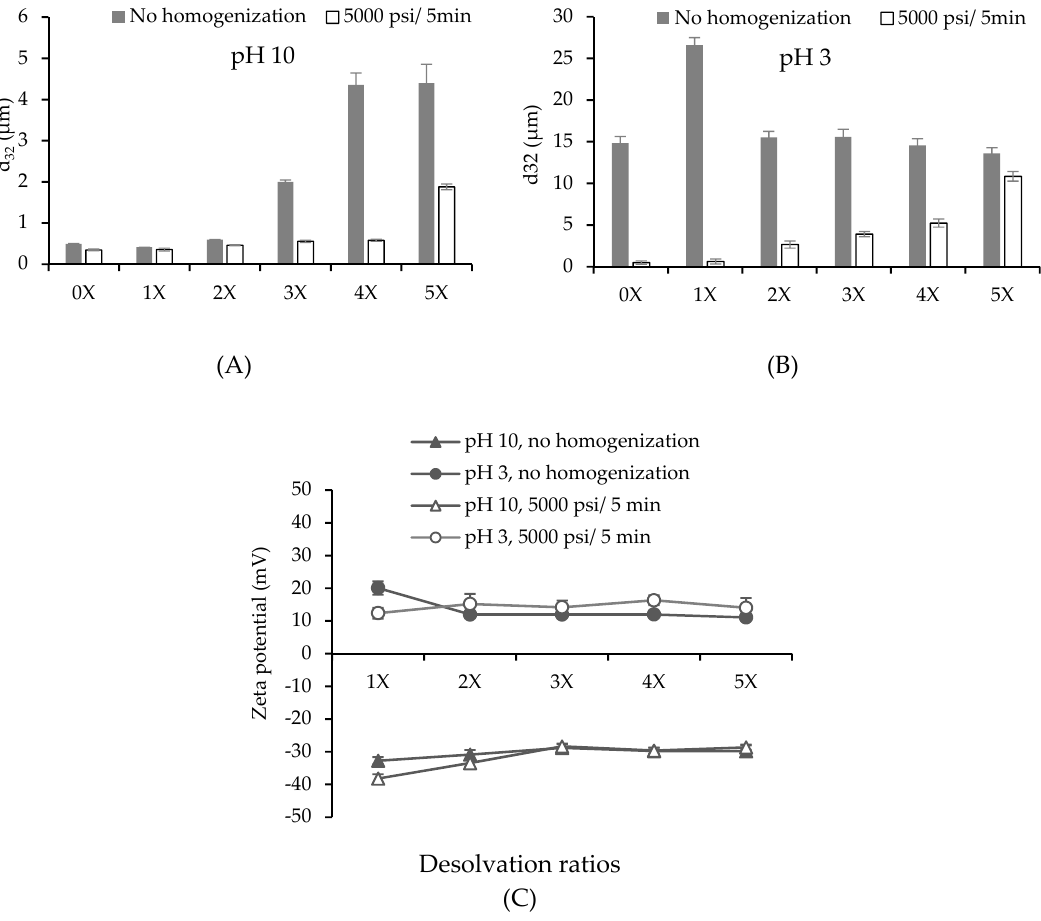
Figure 1. ( A , B ) Effect of ethanol amount on surface average droplet diameter (d 32 ) at pH 10 ( A ) and pH 3 ( B ) before and after homogenization at 5000 psi for 5 min. ( C ) Surface charge of pea protein particles as a function of desolvation ratios at pH 10 and pH 3 before and after high-pressure homogenization.